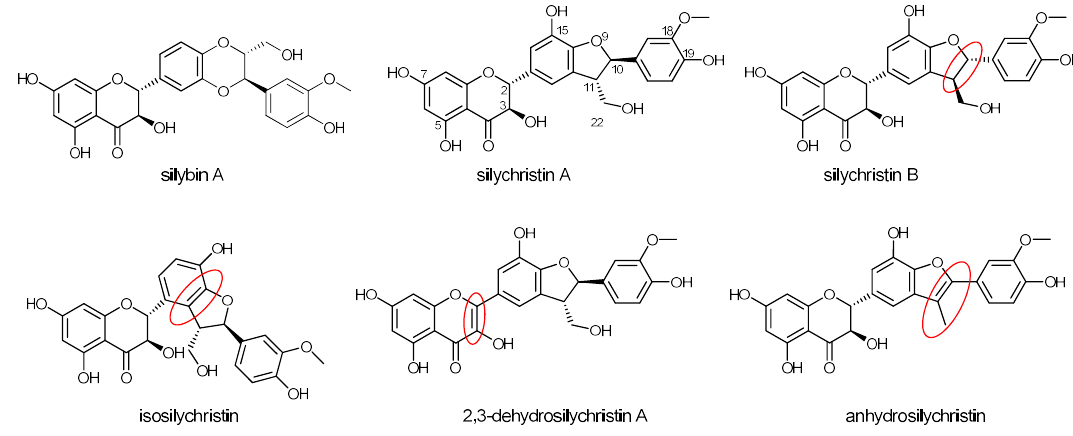
Figure 1. Structure of silychristin diastereomers and derivatives. Major structural differences from silychristin A are highlighted with red ovals. The structure of silybin A is shown for comparison.